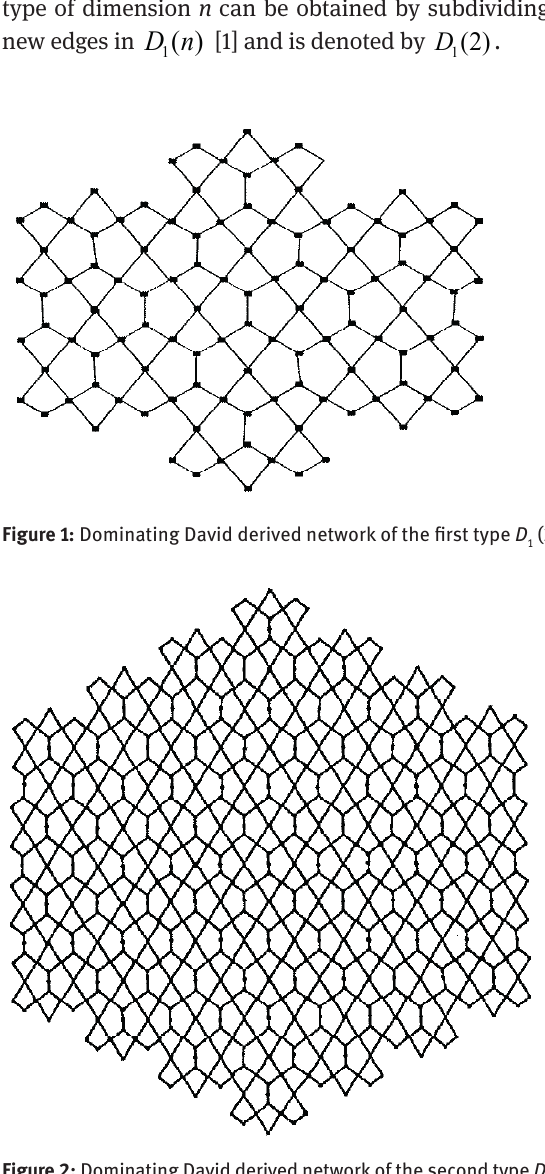
Figure 2: Dominating David derived network of the second type D